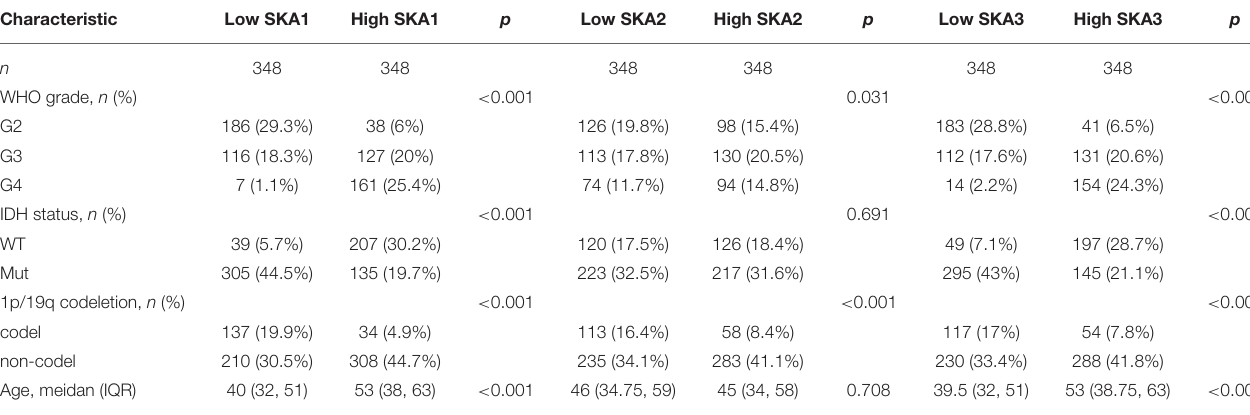
TABLE 1 | Clinicopathological characteristics of gliomas patients from the TCGA database.